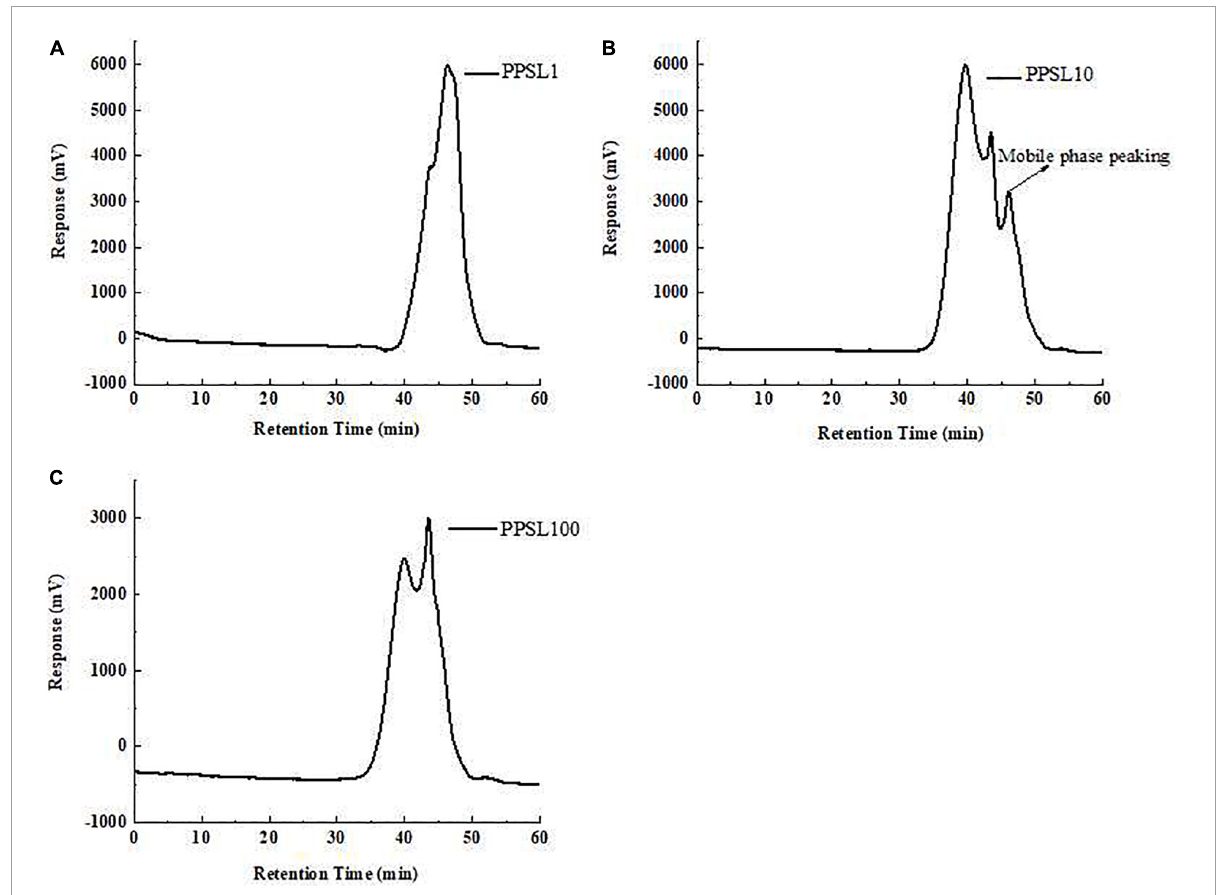
FIGURE1 The average molecular weights of PPSL1 (A) , PPSL10 (B) , and PPSL100 (C) determined by